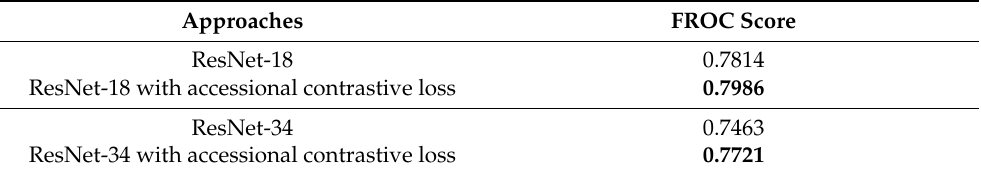
Table 2. Performance evaluation of accessional contrastive